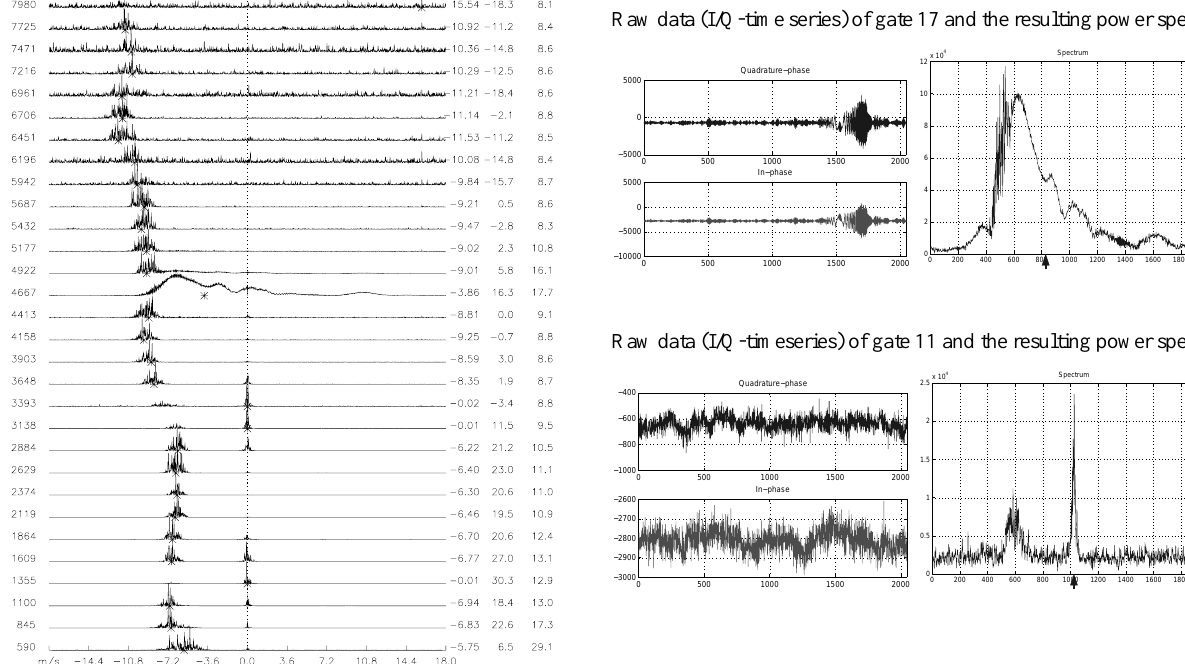
Fig. 3. The left part shows the “stacked spectrum” plot, i.e. the Doppler spectra for each range gate, for the radar dwell at 08:53:38 UTC on 1 December 1999. The right figures give a detailed look into the raw data (I/Q-timeseries) and the Doppler spectrum for the gates 11 and 17 (whose data will be wavelet processed). The black arrows indicate the estimated first moment (i.e. the radial